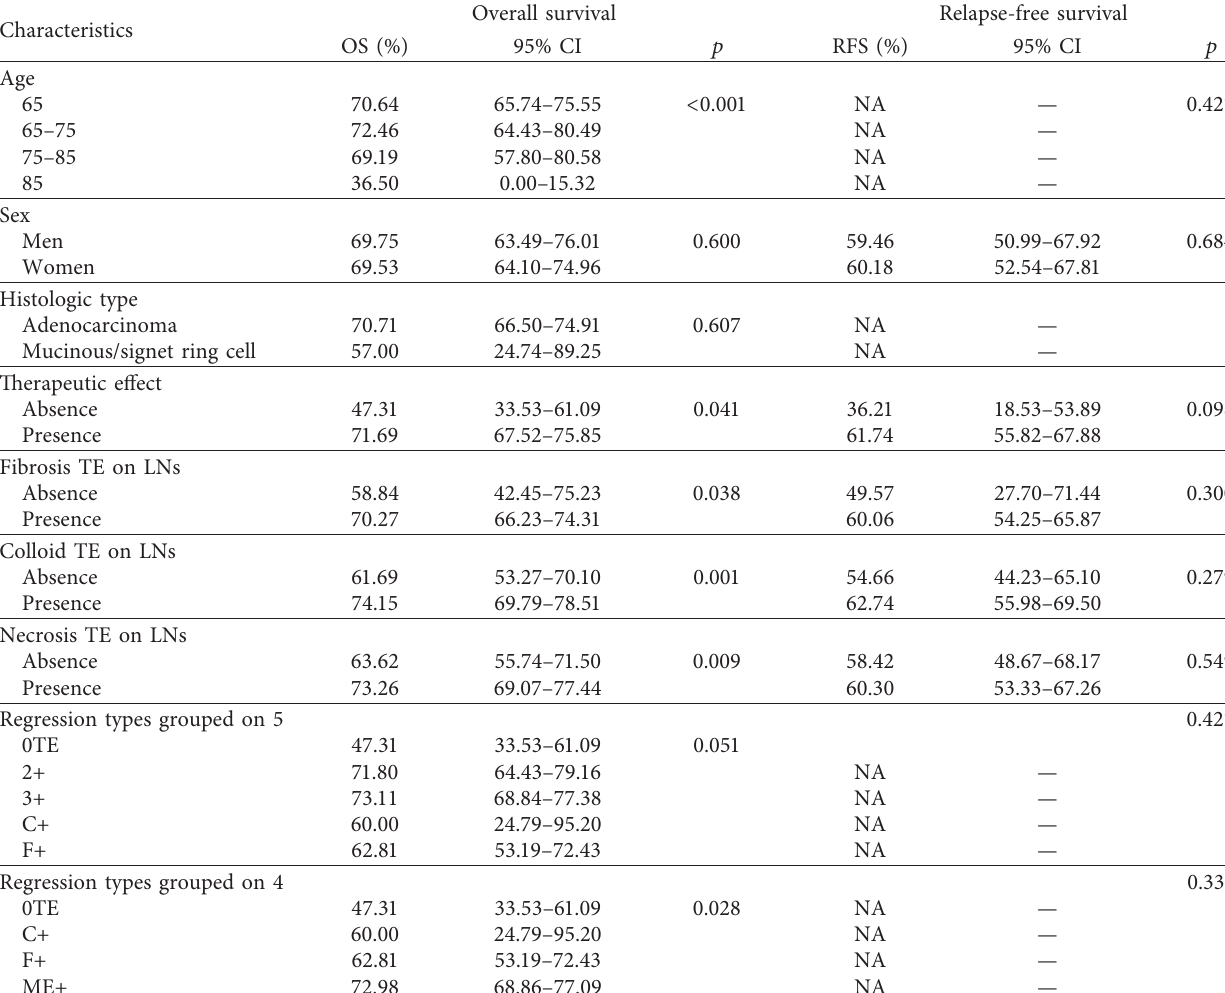
Table 2: Univariate analysis for OS and RFS among patients with rectal cancer according to different